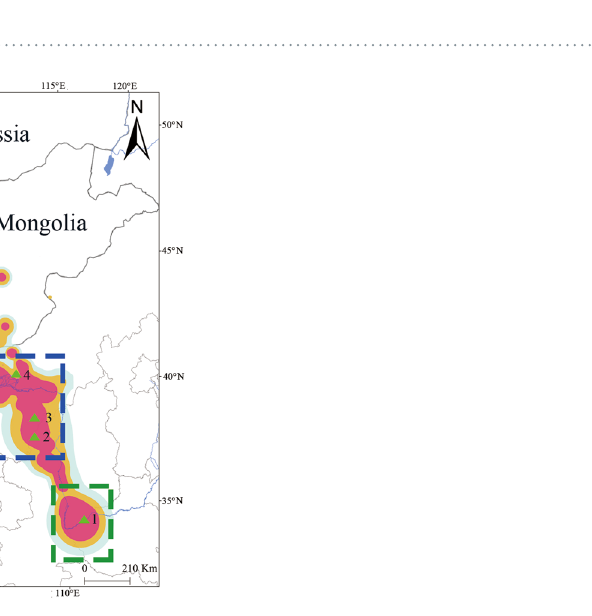
Table 1. Stopover and breeding sites of the spring migration routes of whooper swans in China and Mongolia. S: Stopover site. B: Breeding site.